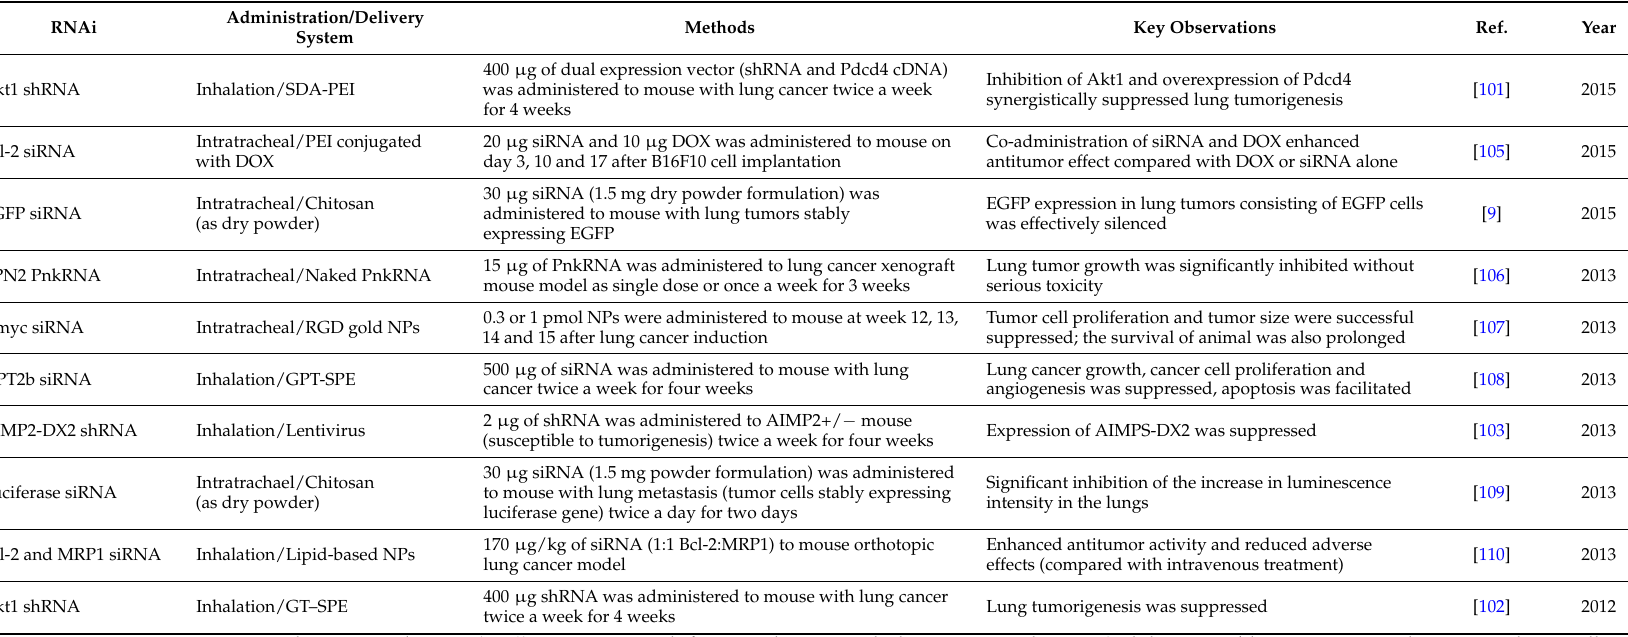
Table 2. Selected in vivo studies of inhaled RNAi therapy on the treatment of lung cancer in the past five years.